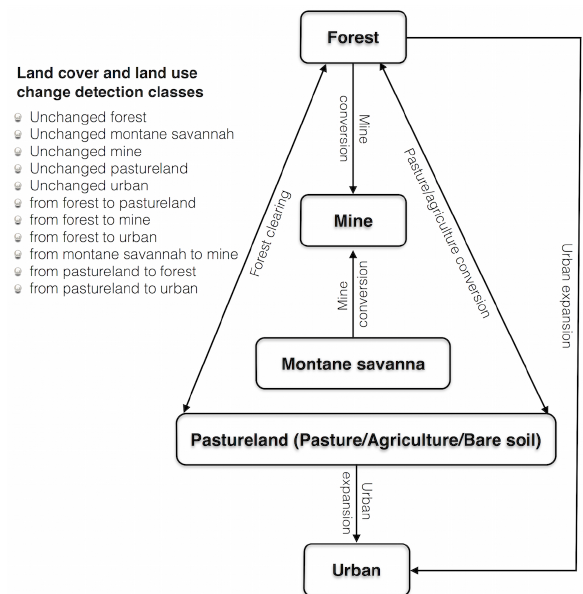
Figure 3. Conceptual model of trajectories of land cover and land use changes over time in the Itacaiúnas River watershed.